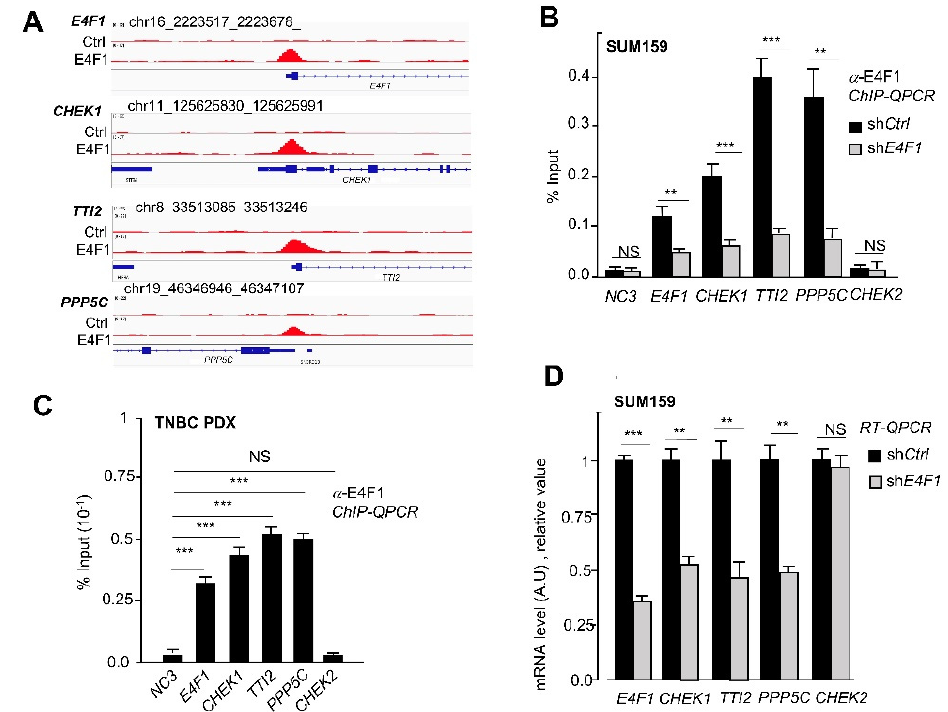
Figure 3. E4F1 directly binds and controls the CHEK1 , PPP5C , TTI2 and E4F1 genes in the TNBC cell line SUM159 and in a primary TNBC tumor-derived xenograft (TNBC PDX). ( A )—ChIP-Seq read densities detected at the CHEK1 , PPP5C , TTI2 genes and at the E4F1 gene itself, in SUM159 cells using either anti-E4F1 [17] or control antibodies. Tag densities were calculated using the HOMER Suite and visualized with CISGENOME browser; ( B )—ChIP-qPCR validation of the